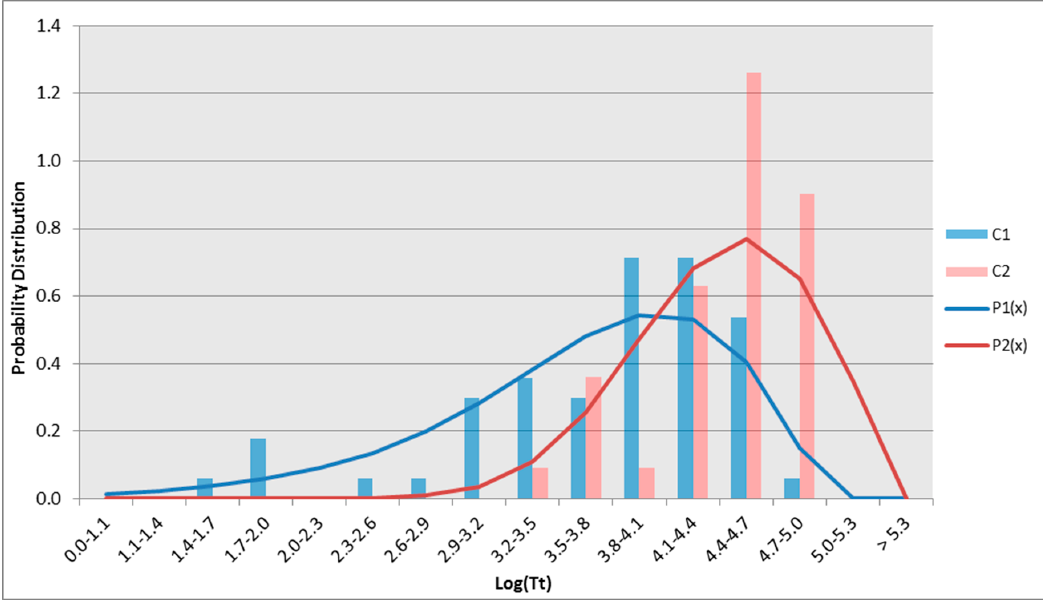
Figure 4. Distribution functions P 1 ( x ) and P 2 ( x ) for x = log(T T ) on Clusters 1 and 2, respectively. The continuous lines represent logarithmic fits to the actual histograms using the cumulative distribution functions and are used here to accurately determine β 1,2 using Equation (1).